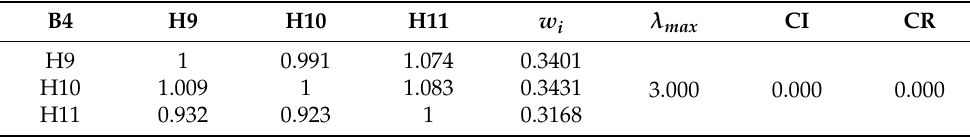
Table 10. Personal motivation judgment matrix and weight values.